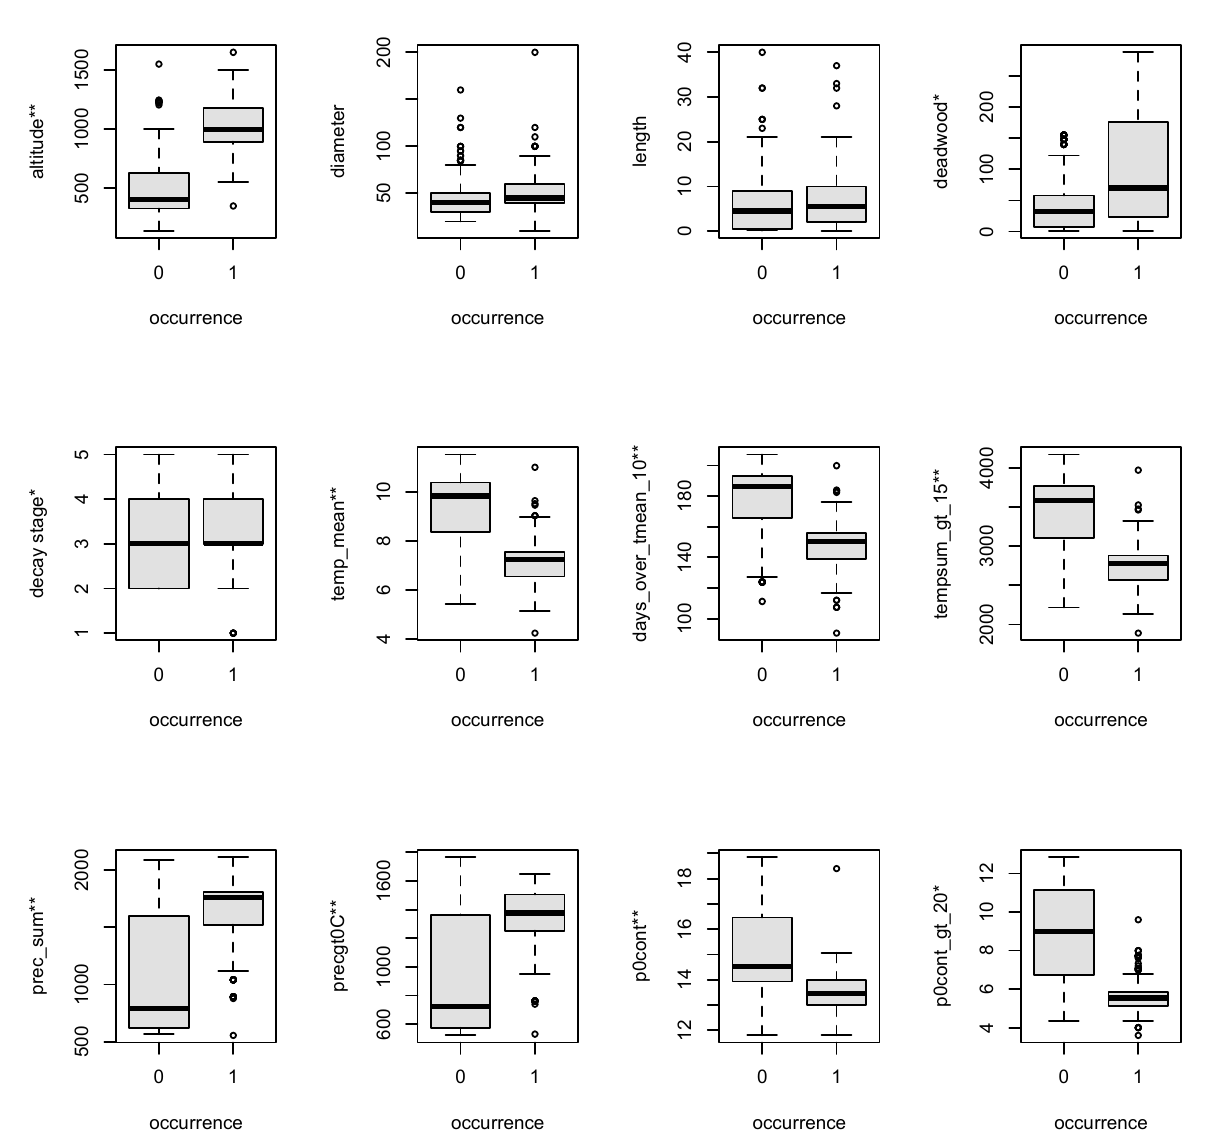
Figure 1. Boxplots for not populated (=0) and populated sites (=1) regarding the climate variables (for abbreviations see Table 1); * and ** give information on the p -value’s significance (* = p < 0.05, ** = p < 0.01). Table 1. List of climatic variables used in the analysis.